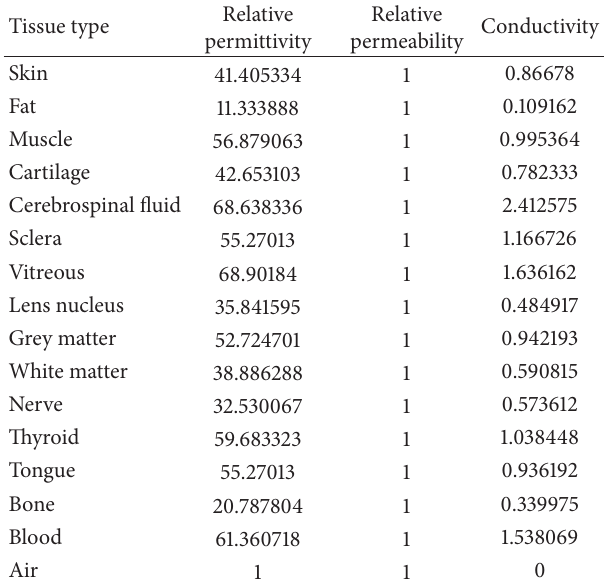
Table 1: The HPC hardware information.